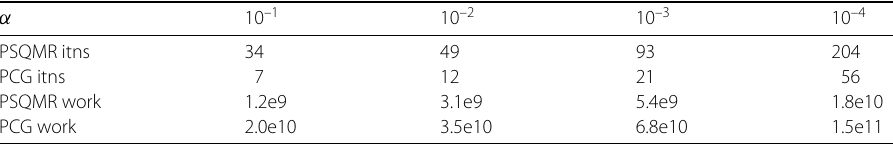
Table 2 Iterations and flop counts for the reduced Hessian and KKT solvers